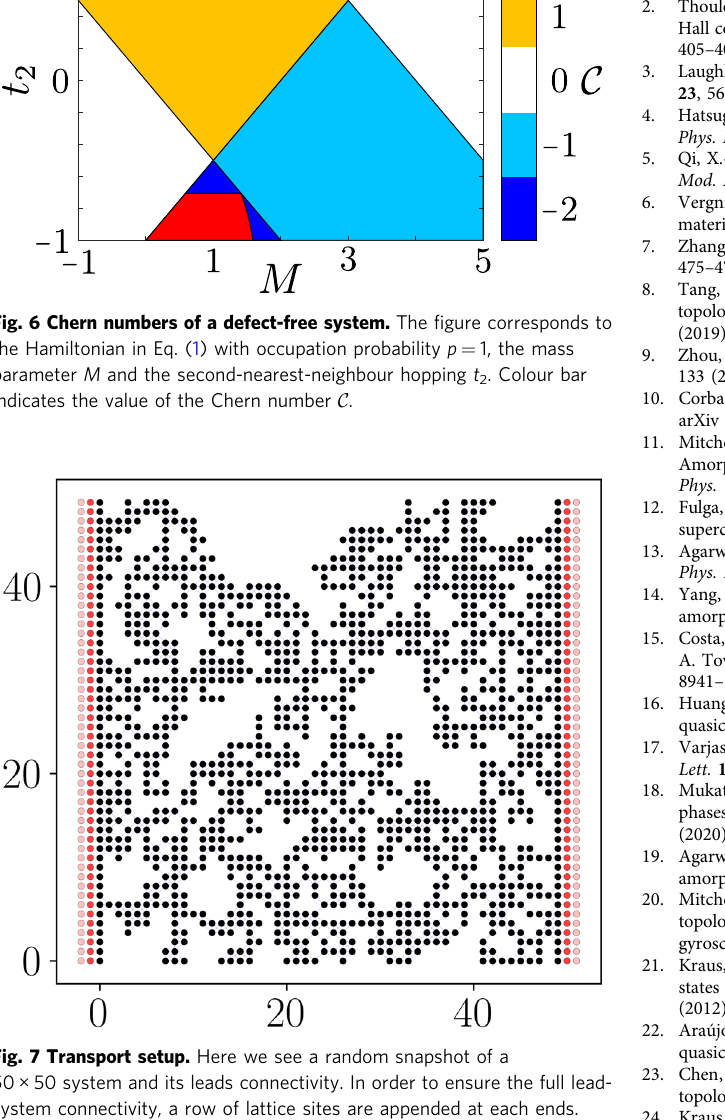
linear system sizes L = 120 − 1600.